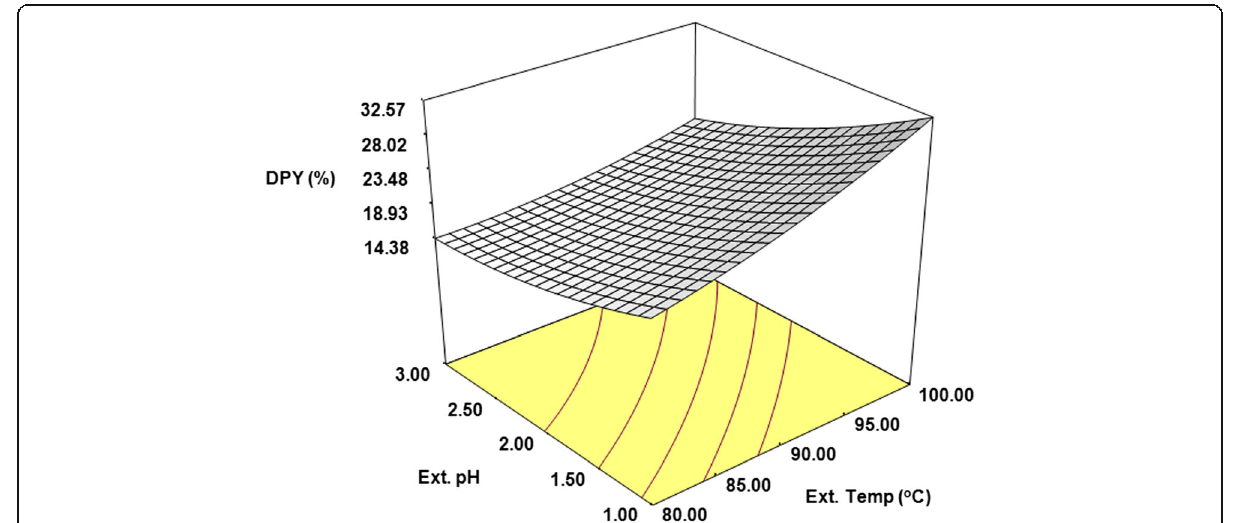
Fig. 3 Response surface plot of the effect of extraction temperature and extraction pH on dried pectin yield